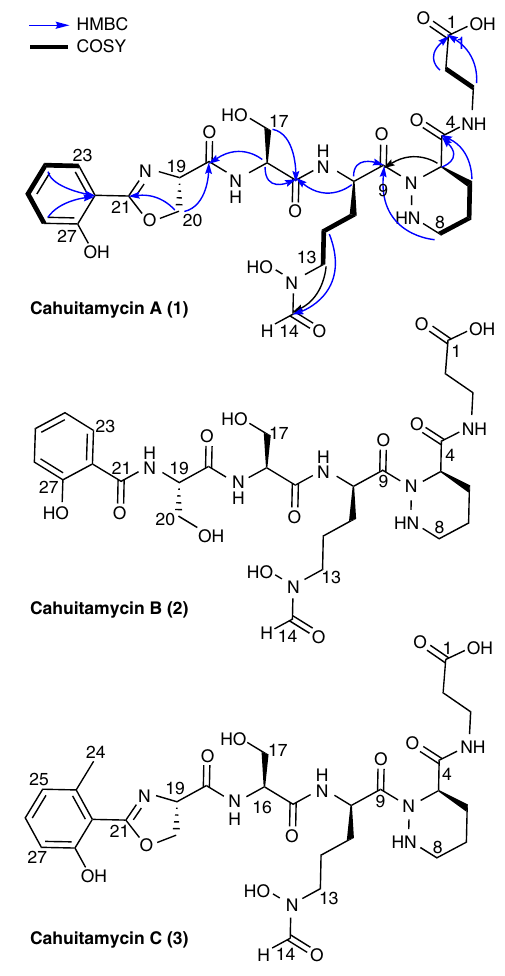
Figure 1 | Structures of cahuitamycins A–C (1–3) with absolute stereochemistry. Cahuitamycin A shows key HMBC and